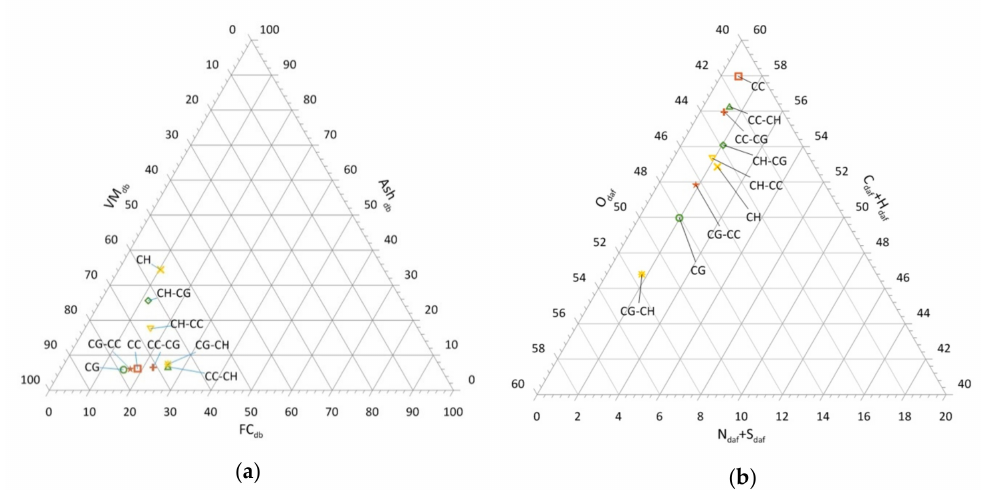
Figure 1. Physicochemicalpropertiesofthetestedbiomassbasedon( a )proximateand( b